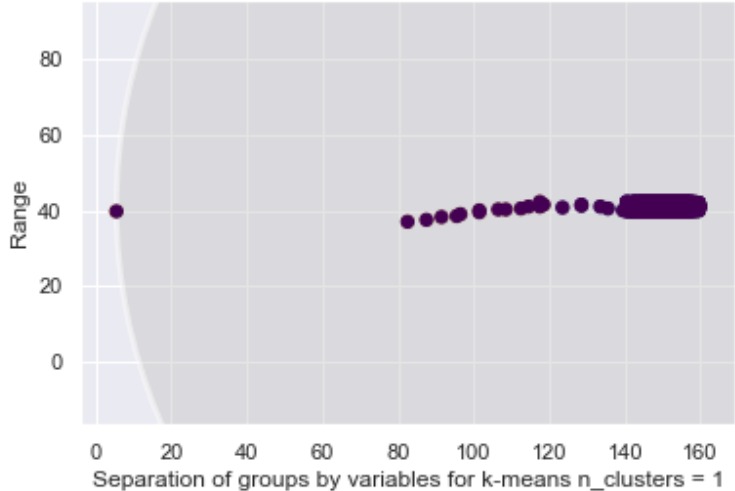
Figure 16. The K-Means between temperature and heartbeat, without constrain.